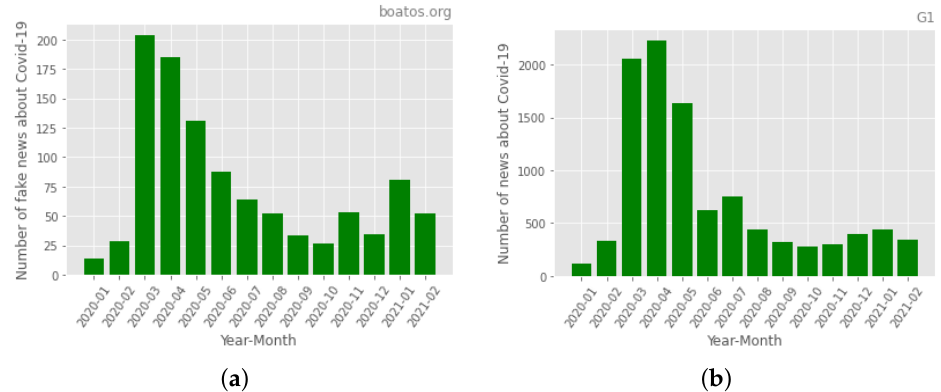
Figure 2. Monthly distribution of ( a ) fake news items and ( b ) true news items about COVID-19 in the